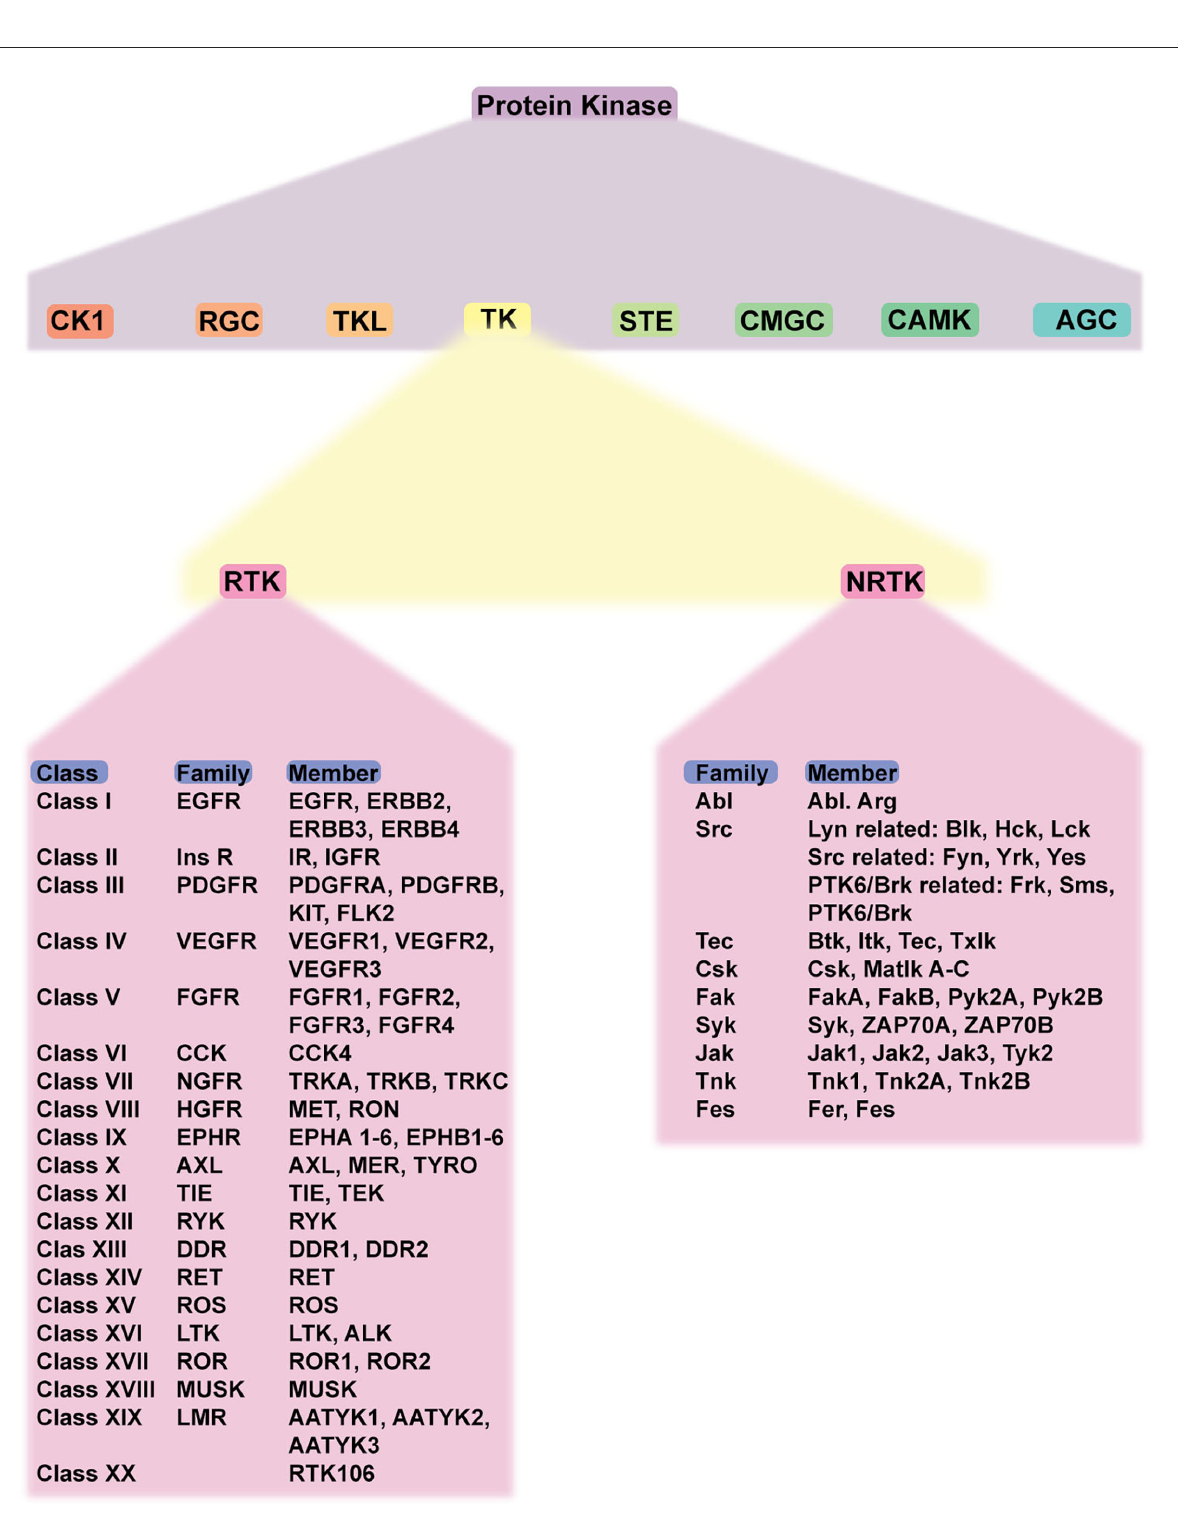
FIGURE1 Schematic classification of protein kinases and detailed classification of tyrosine kinases. Protein kinase has eight members, including TK. TK is classified into RTK and NRTK which are subdivided into classes and families. Abbreviations: CK1, casein kinase; RGC, receptor guanylate cyclase; TKL, tyrosine-kinase like; TK, tyrosine kinase; STE, serine/threonine kinase; CMGC, CDK-MAPK-GSK-CDK-like kinase; AGC, protein kinase A, G, C; RTK, receptor tyrosine kinase; NRTK, non-receptor tyrosine kinase; EGFR, epidermal growth factor receptor; PDGFR, platelet-derived growth factor receptor; VEGFR, vascular endothelial growth factor receptor; FGFR, fibroblast growth factor receptor; CCK, cholecystokinin; NFGR, nerve growth factor receptor; HGFR, hepatocyte growth factor; EPHR, ephrin receptor; AXL, anexelekto receptor; TIE, Tek receptor tyrosine kinase; ALK, anaplastic lymphoma kinase; RYK, receptor-like tyrosine kinase; ROR, receptor tyrosine kinase-like orphan receptors; MUSK, muscle-specific